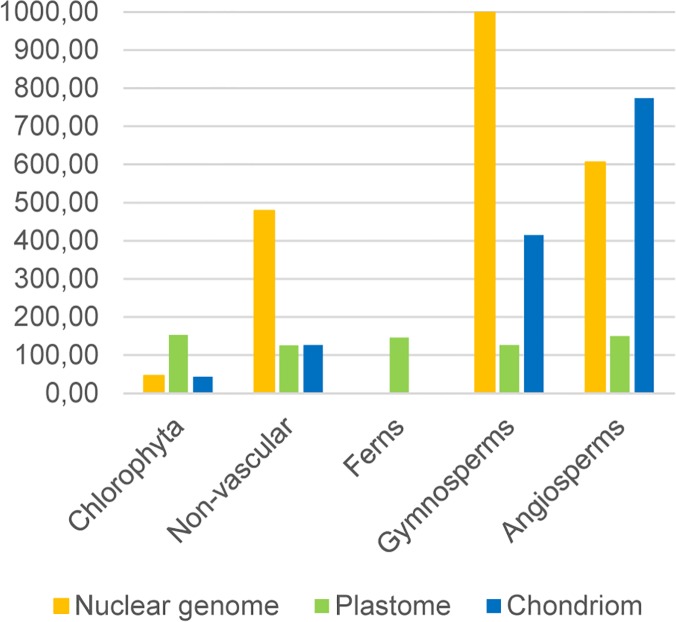
The average size in Mbps of the nuclear (orange), plastid (green) and mitochondrial (blue) genomes in phylogenetic groups.The plastome size remains similar in all the groups, whereas the chondriome seems to be inflating as plants are becoming more complex. The average genome size of gymnosperms is out of the scale due to the extremely large genome of Picea glauca, and the low number of species sequenced in the group.